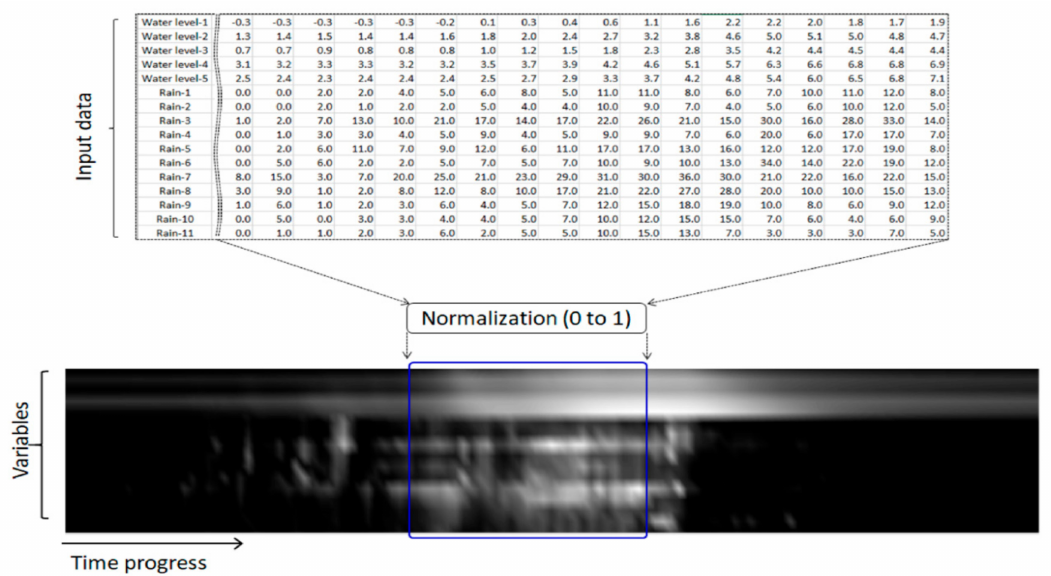
Figure 6. Sample data conversion from time-series data to image data.